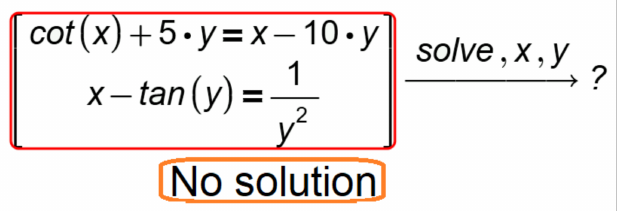
Figure 2. Mathcad instructions for the symbolic solution of (1).